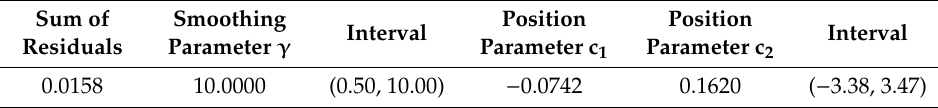
Table 4. Initial estimation results of smoothing parameters and positional parameters.